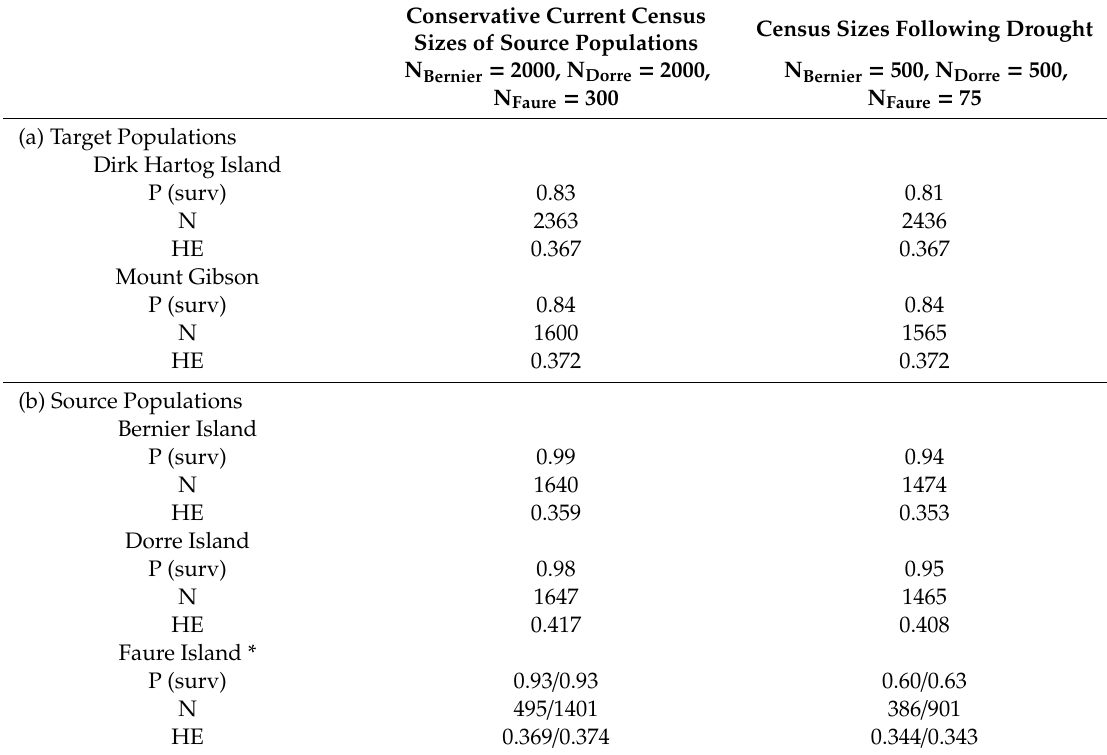
Table 6. Comparison of population viability analysis (PVA) outputs after 50 calendar years when harvesting source populations using either current conservative source census sizes, or likely source census sizes following droughts. Models are based on scenario 8, describing recent and ongoing movement of L. fasciatus , and assuming an average drought frequency of 1 in 6.25